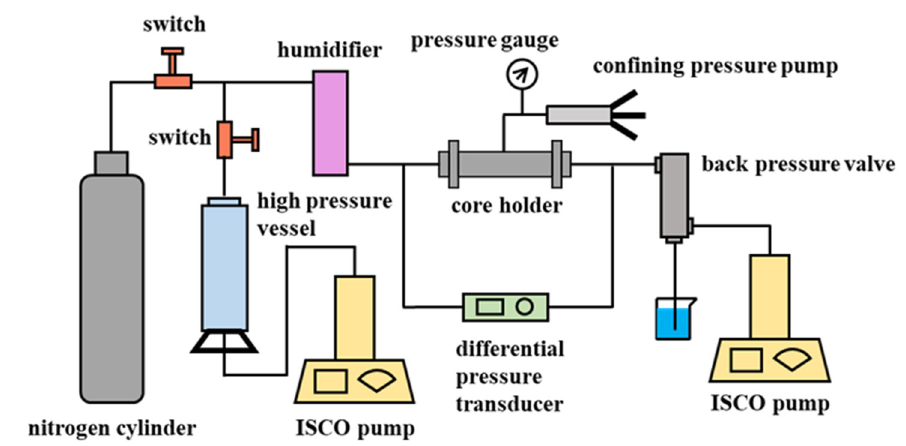
Figure 1. Schematic of the threshold pressure gradient experiment.